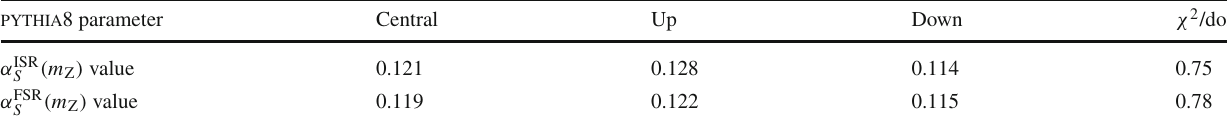
( m ) or α FSR ( m ) is treated as a free parameter Z Z S S